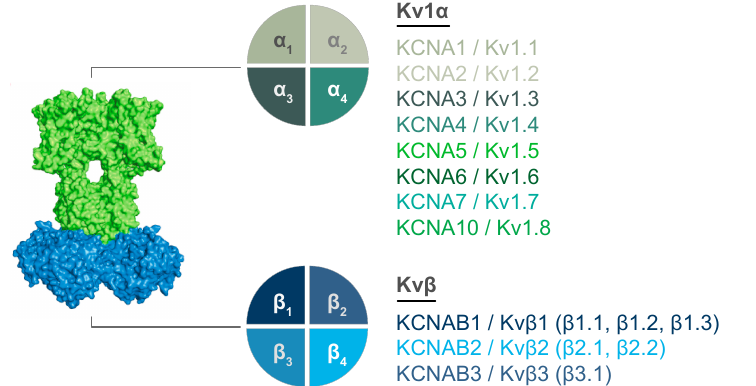
Figure 2. Molecular diversity of Kv1 complexes. Potential interacting subunits are show for Kv1 α ( top ) and Kv β ( bottom ) tetrameric structures. Gene names and corresponding proteins are listed. Known splice variants for Kv β proteins are listed for each Kv β in parentheses.